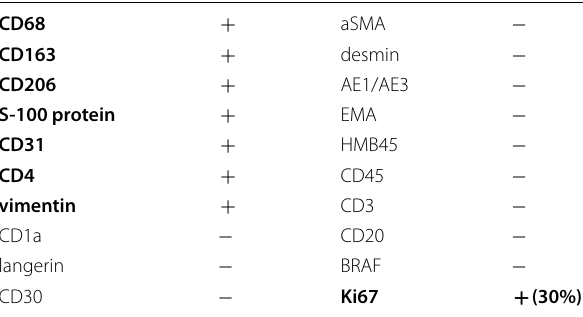
Table 1 Summary of immunohistochemistry results